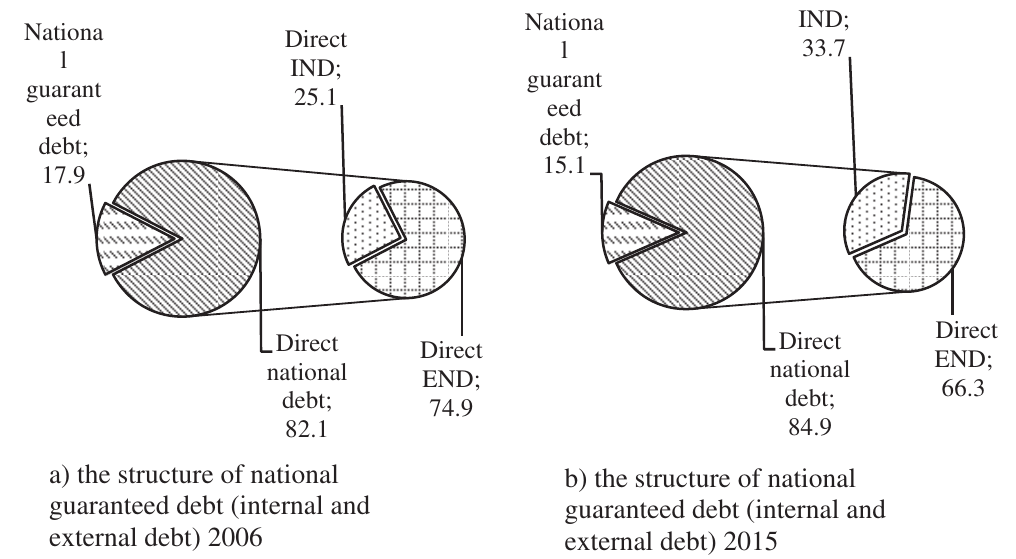
Fig. 3. The structure of national guaranteed debt (internal and external debt) as of end of 2006 and